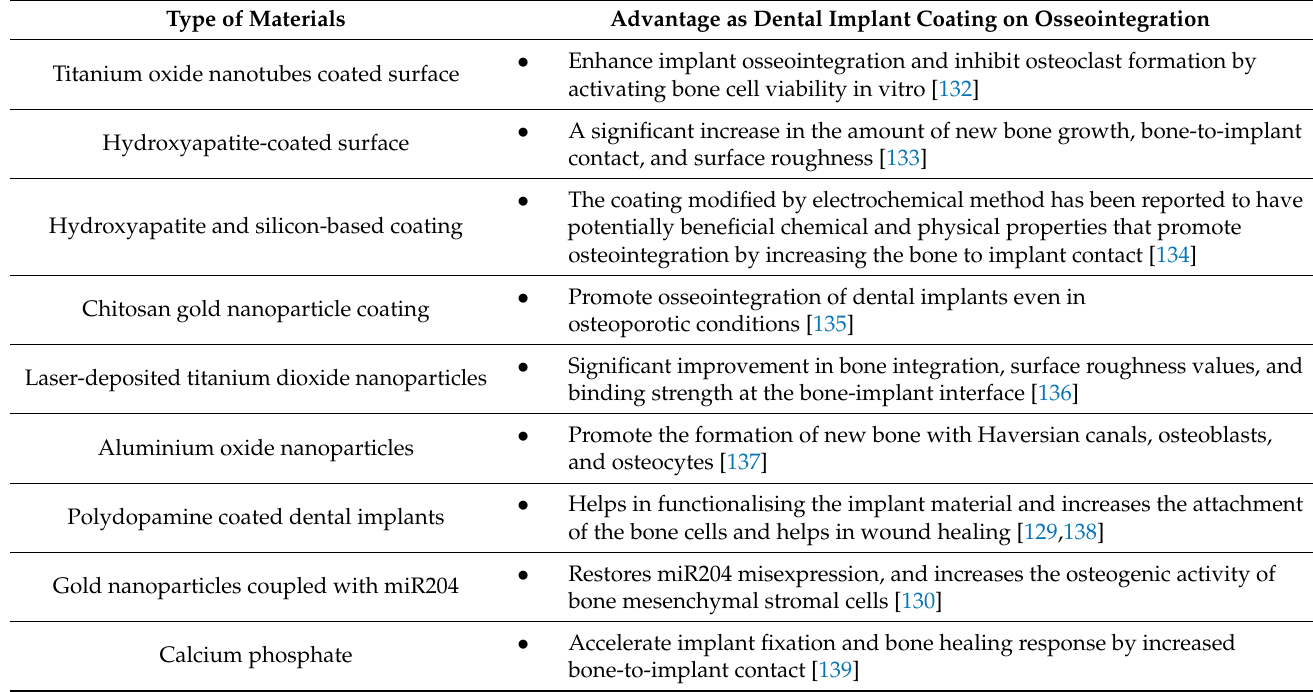
Table 2. Different materials used for dental implant surface coating to improve